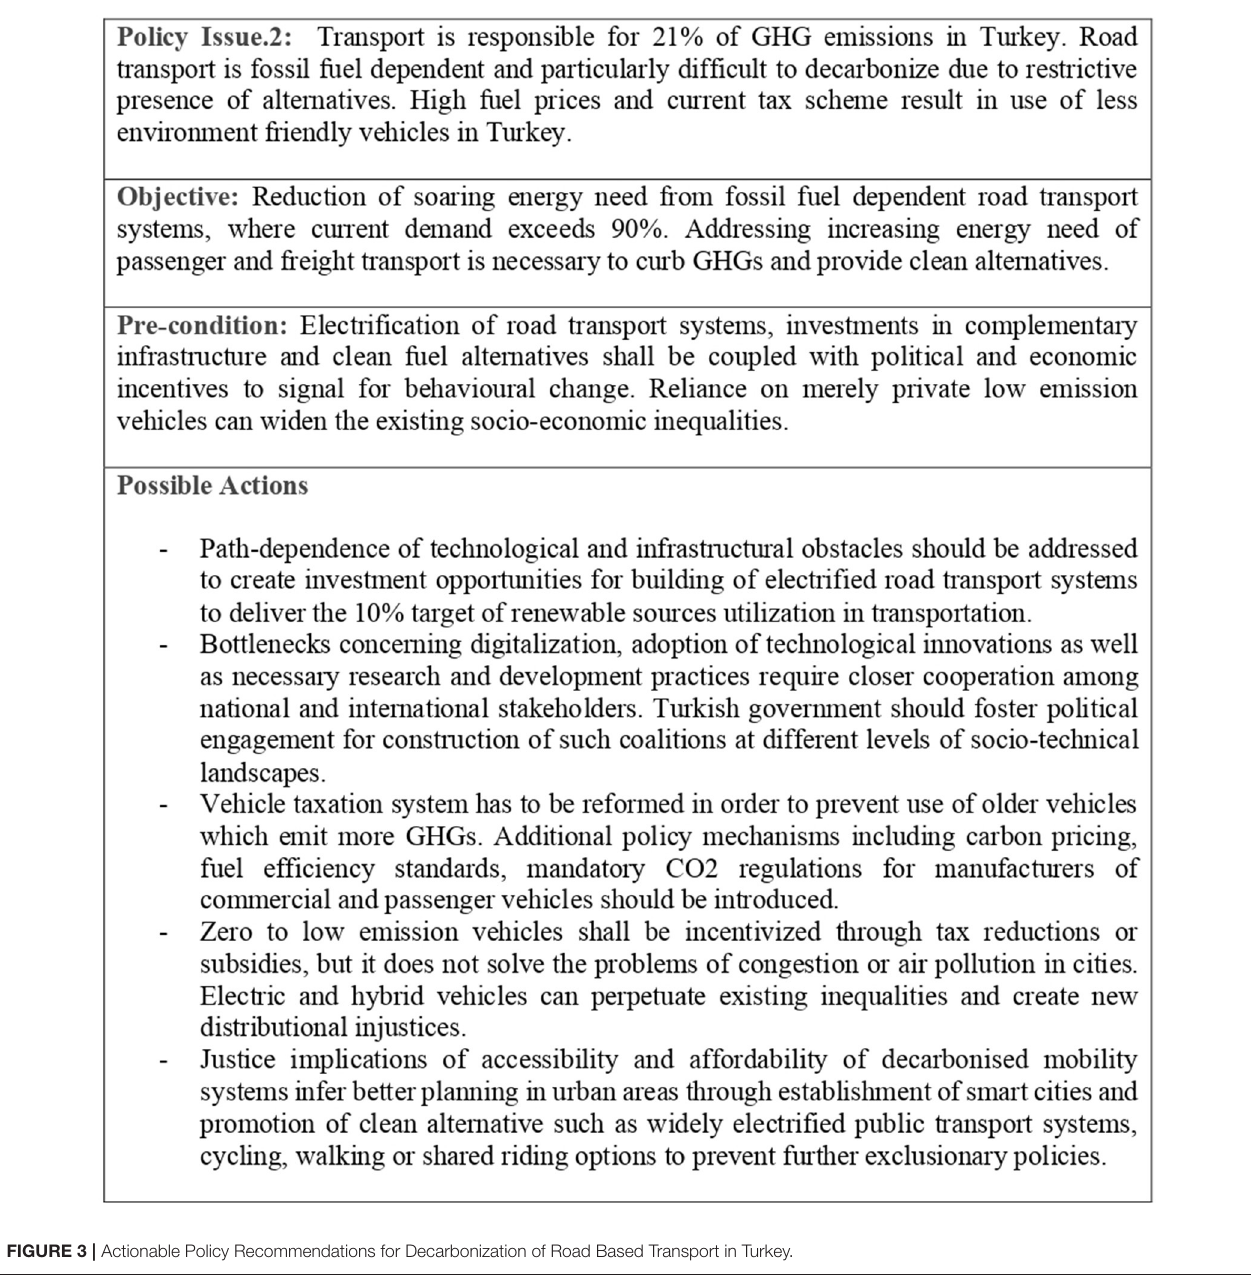
FIGURE 3 | Actionable Policy Recommendations for Decarbonization of Road Based Transport in